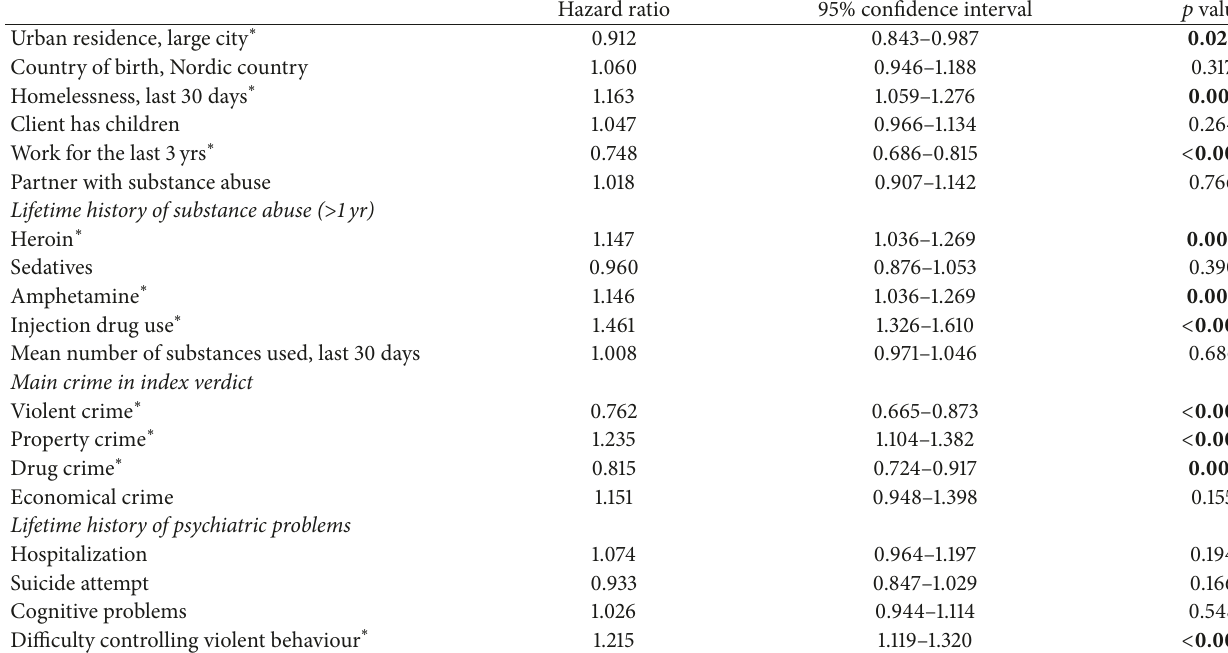
Table 6: Men: risk factors for criminal